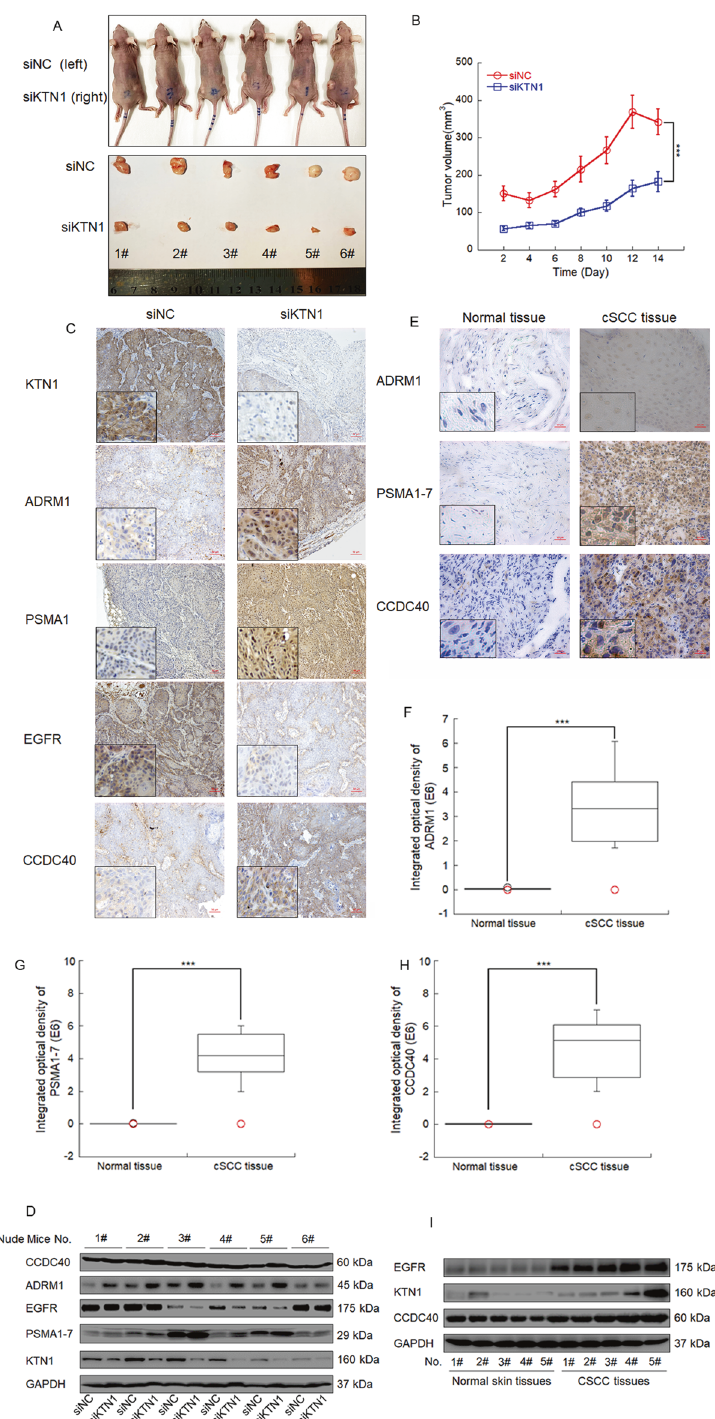
Fig. 8 In vivo function of the EGFR degradation regulatory axis triggered by KTN1. A , B Tumorigenicity of KTN1 depletion and control A431 cells in nude mice. siKTN1-transfected or siNC-transfected A431 cells (0.1 mL; 2 × 10 6 cells) were injected into different sides of nude mice. Tumor growth was measured every 2 days. Two weeks later, the mice were sacri fi ced to collect the tumor samples. Photo credit: Ji Ma, Department of Radiation medicine, School of Public Health, Southern Medical University. Tumor volumes represent the means ± SD. C Representative photos of immunohistochemistry (IHC) staining with anti-PSMA1 – 7, anti-ADRM1, anti-EGFR, anti-CCDC40, and anti-KTN1 for the xenograft tumor model. D Lysates of the xenografted tumors were subjected to immunoblotting with anti-PSMA1 – 7, anti-ADRM1, anti- EGFR, anti-CCDC40, or anti-KTN1. E – H Representative photos and integrated optical densities of immunohistochemistry (IHC) staining with anti-PSMA1 – 7, anti-ADRM1, and anti-CCDC40 for normal human tissues and human cSCC tissues. Data represent the means ± SD. I Lysates of normal human tissues and human cSCC tissues were subjected to immunoblotting with anti-PSMA1-7, anti-ADRM1, or